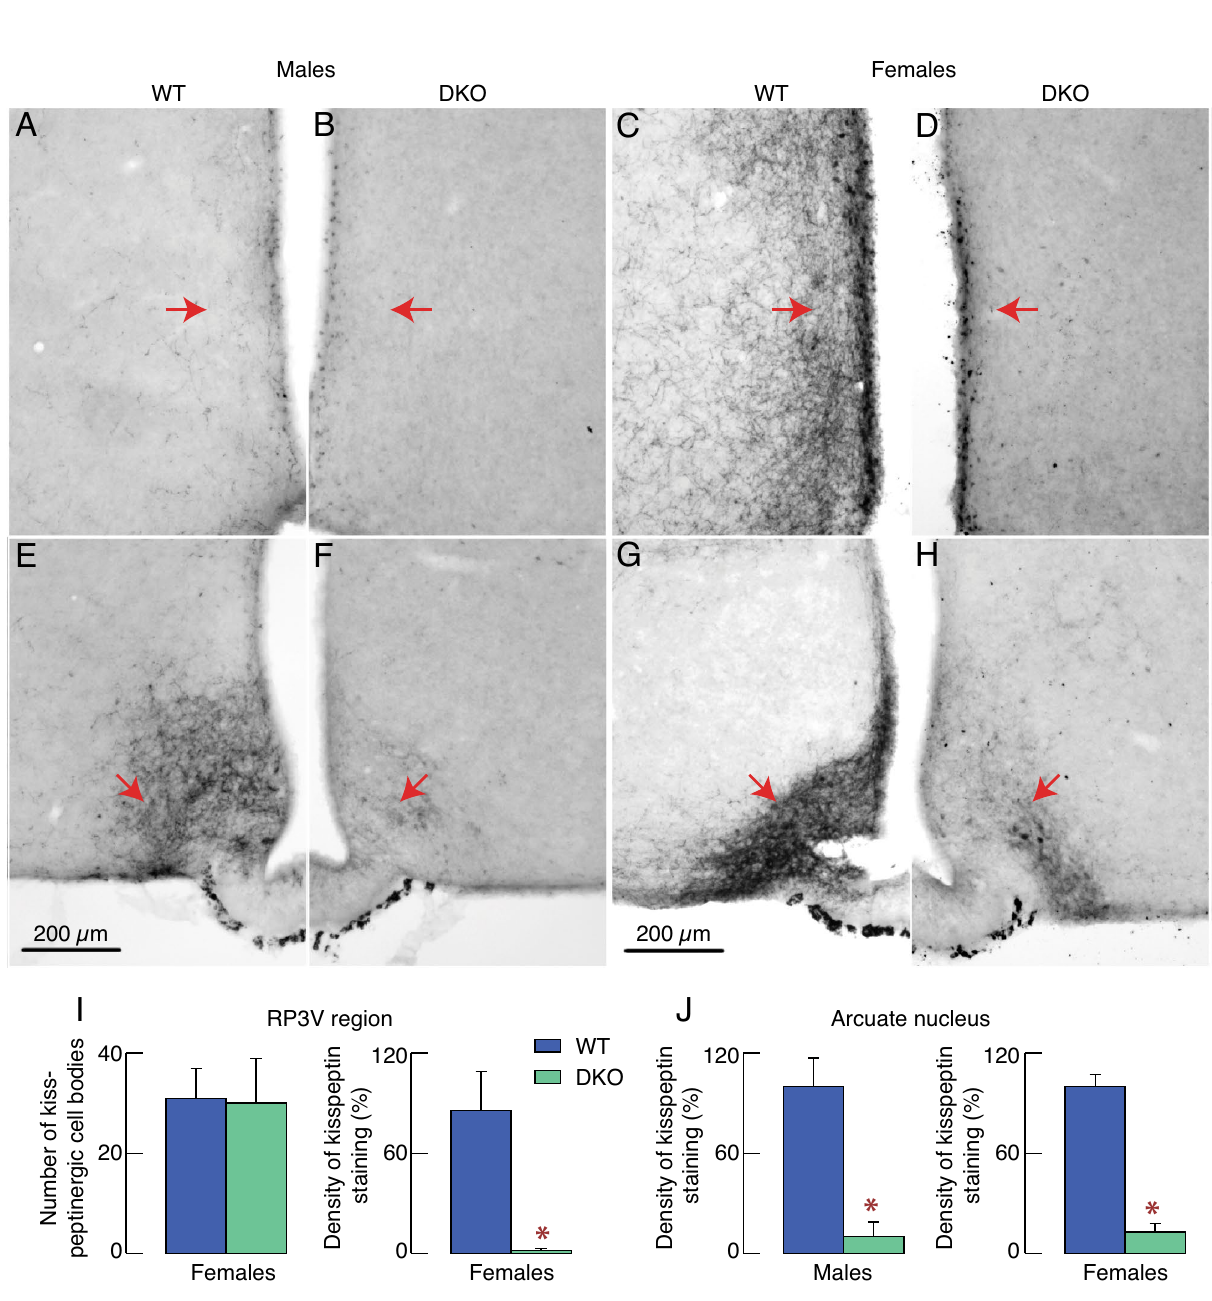
Figure 8. Common and female-specific effects of DKO on the hypothalamic kisspeptin-secreting neurons. ( A–D ) Kisspeptin immunoreactivity in the rostral periventricular region of the third ventricle. Pattern of kisspeptin immunoreactivity of WT (A) and DKO males (B) and WT (C) and DKO females (D). ( E – H ) Kisspeptin immunoreactivity in the arcuate nucleus. Pattern of kisspeptin immunoreactivity of WT (E) and DKO males (F) and WT (G) and DKO females (H). Horizontal bars of 200 μm apply to all panels. Arrows indicate representative fiber density in the RP3V (A – D) and the arcuate nucleus (E–H). ( I ) Quantification of kisspeptinergic cell bodies (left panel) and fiber densities (right panel) in the RP3V region of WT and DKO females whose representative matched sections are shown in C-D. ( J ) Quantification of kisspeptinergic fiber densities in the arcuate nucleus of WT and DKO males (left panel) and females (right panel) whose representative matched sections are shown in E–F and G–H,